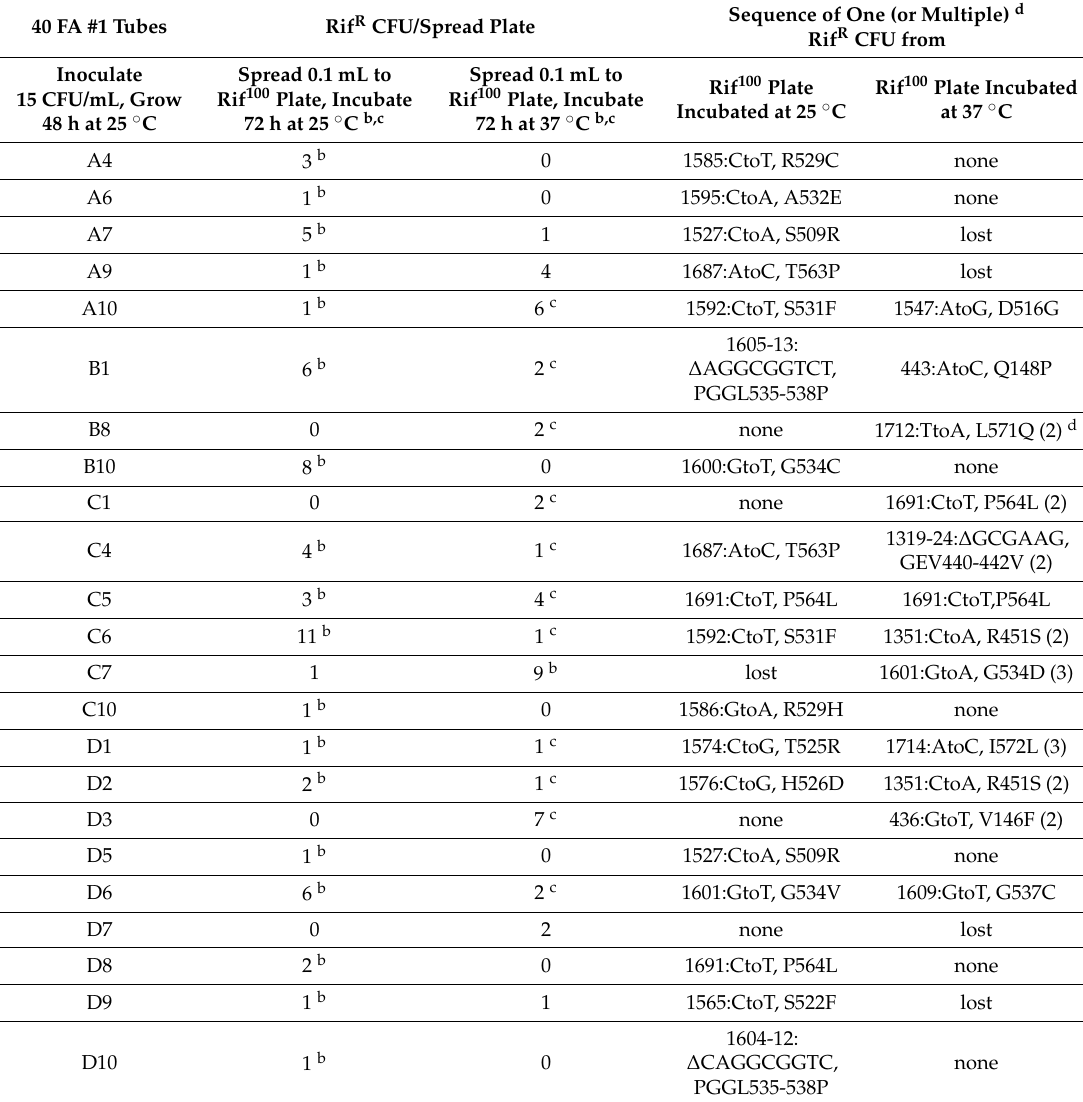
Table 5. Isolation and characterization of Rif R CFU from 40 fluctuation assay (FA #1) tubes a . 40 FA #1